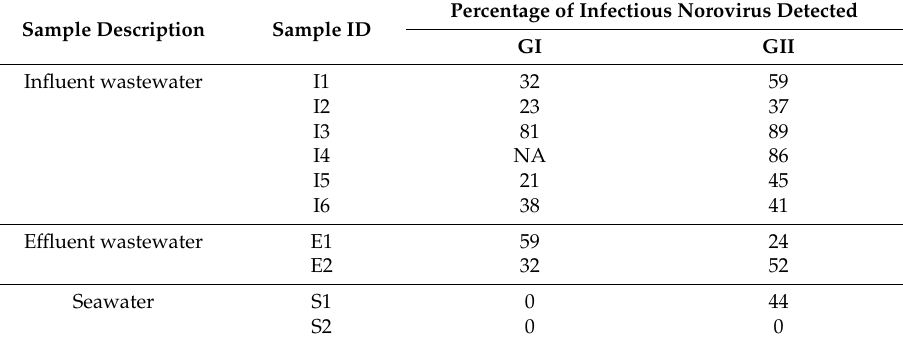
Table 3. Percentage of infectious norovirus GI and GII in wastewater and seawater samples as determined by PEMAX TM -RT-qPCR.